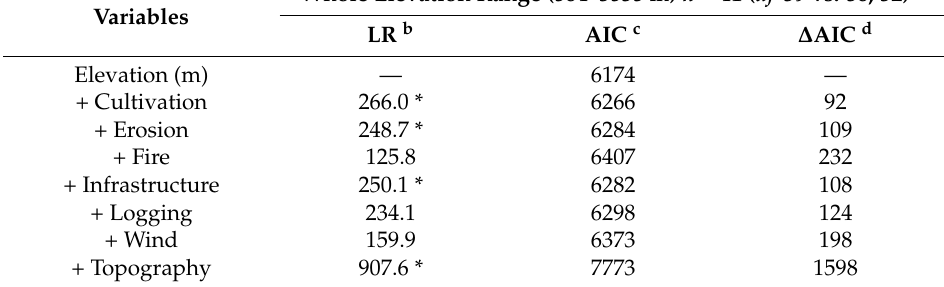
Table 1. Summary of model comparisons between elevation effect alone and elevation effect plus one of the other environmental effects across the whole elevation range of sampled forest sites in the Cusco region of Peru.